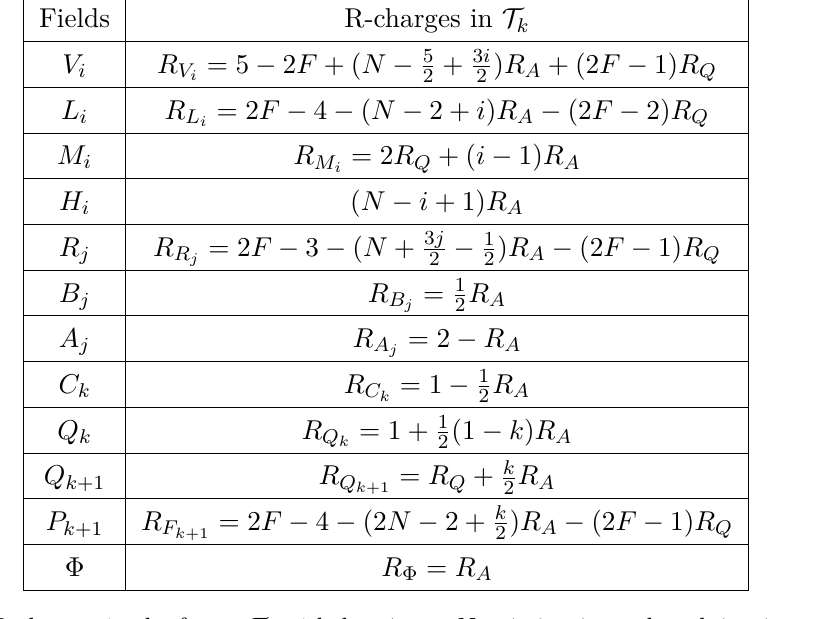
Table 1 . R-charges in the frame T k with k = 1 , . . . , N − 1 , i = 1 , . . . , k and j = 1 , . . . , k − 1